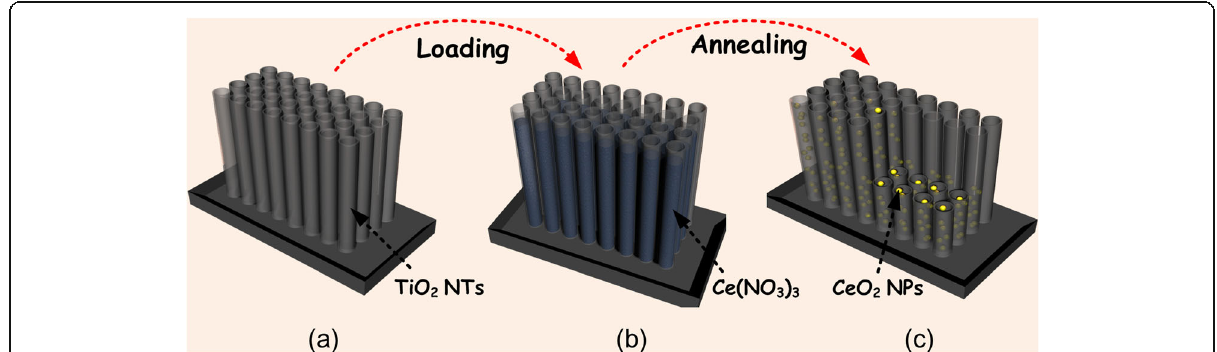
Fig. 2 Synthesis flow of CeO 2 /TiO 2 heterojunction: (a) preparation of empty TiO 2 NTs, (b) loading the TiO 2 NTs with Ce(NO 3 ) 3 solution, and (c) formation of CeO 2 /TiO 2 heterojunction